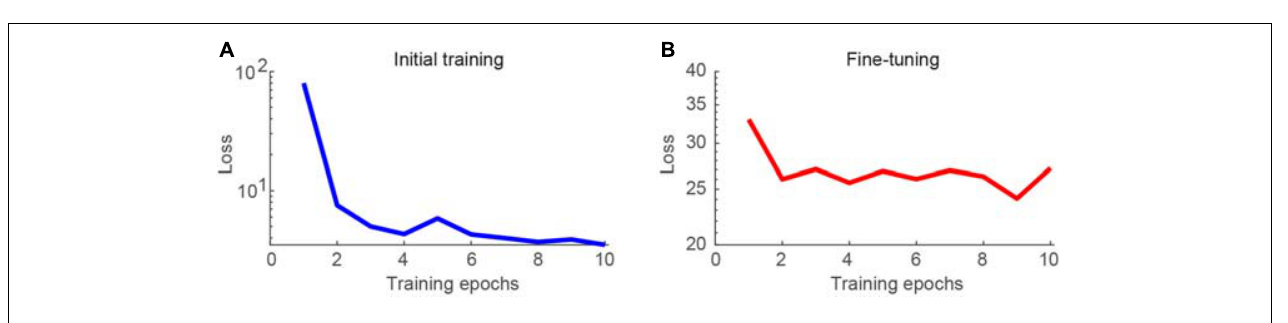
FIGURE 2 | Learning curves for training the network model. (A) Training loss as a function of epoch for initial training of the network, visualizing for the first 10 epochs. (B) Training loss as a function of epoch for fine-tuning of the